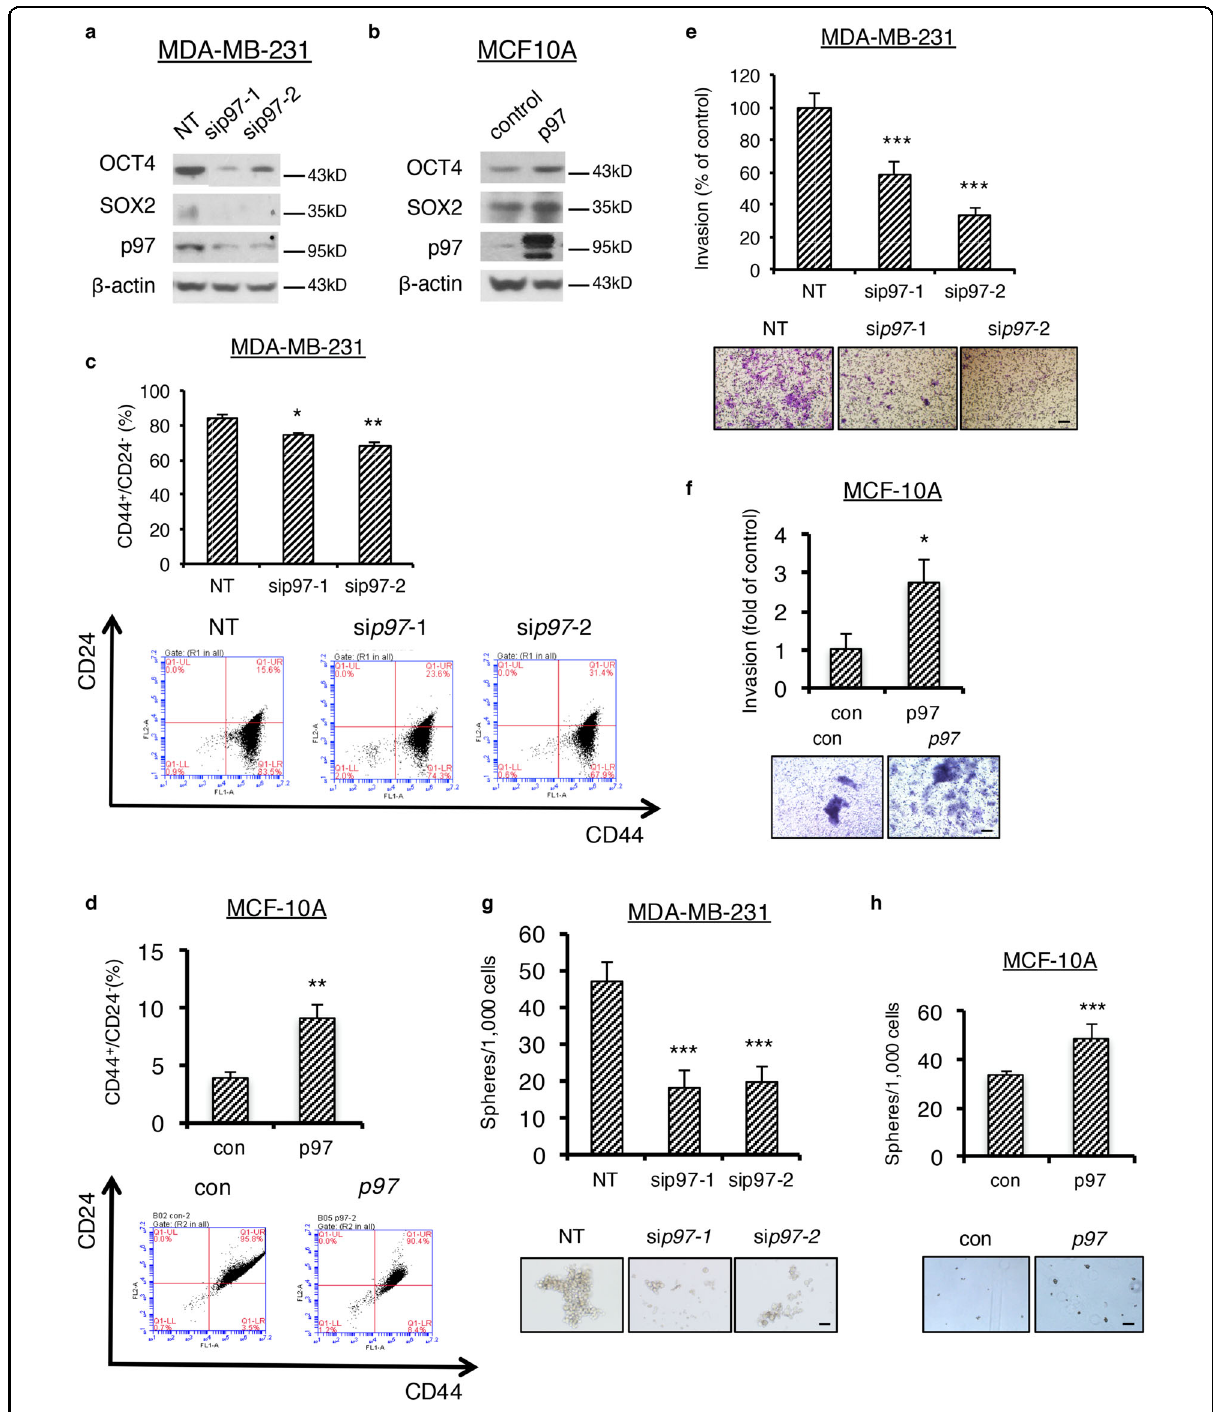
Fig. 3 p97 levels control stemness regulator expression, CSC population, cancer invasiveness, and mammosphere formation. a , b Immunoblotting analysis of OCT4, SOX2, and p97 in MDA-MB-231 cells with p97 silenced or MCF10A cells overexpressing p97. β -actin serves as a loading control. c , d Flow cytometry analysis of CD44 + /CD24 − population in MDA-MB-231 cells with p97 silenced or MCF10A cells overexpressing p97. Upper: the percentage of CD44 + /CD24 − cells. Lower: fl ow cytometry analyses. e , f Transwell invasion of MDA-MB-231 cells with p97 silenced or MCF10A cells overexpressing p97. Upper: percentage of the invaded cancer cells relative to the control group. Lower: representative images of crystal purple staining. Bar: 100 μ m. g , h Mammosphere formation of MDA-MB-231 cells with p97 silenced or MCF10A cells overexpressing p97. Upper: the percentage of spheres formed under each condition relative to the control group. Lower: representative images of the spheres. Bar: 100 μ m. Data were shown as mean + SD. * P < 0.05, ** P < 0.01, and *** P <